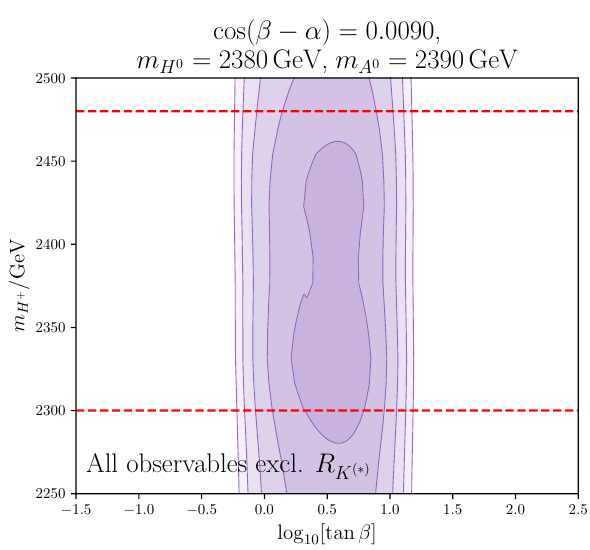
Figure 17. Contour plot of the allowed 2HDM-II parameter space in the (tan β − m obtained by combining all observables excluding R fit point from table 2 and including the restrictions from the theory constraints in table 1 (shown by the red dashed lines). The contours indicate the allowed parameter space at 1 , 2 , 3 , 4 , 5 σ confidence level going from darker to lighter.